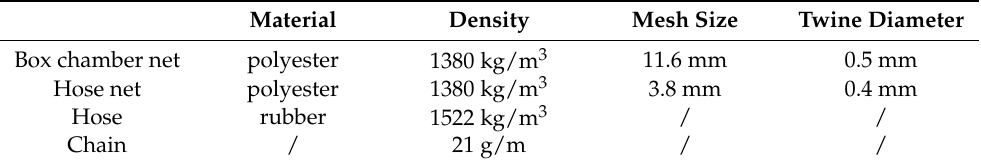
Table 2. Materials of the 1/60 chamber net and hose net used in catch-hauling tests.